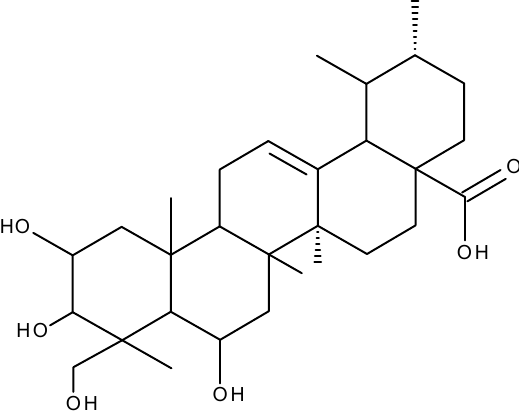
Figure 13. Structure of madecassic acid.